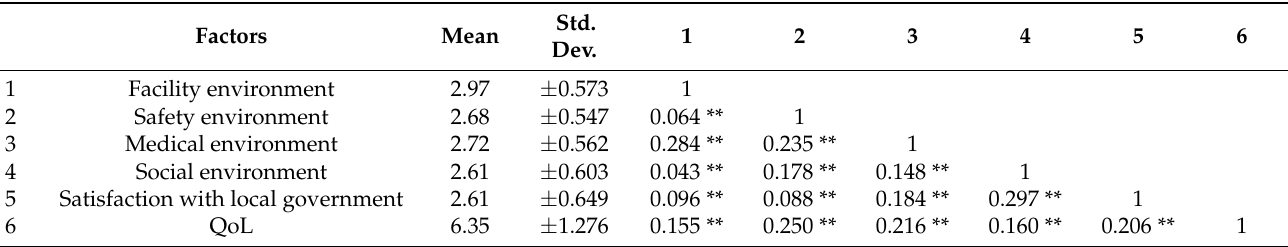
Table 4. Descriptive statistics and correlations between